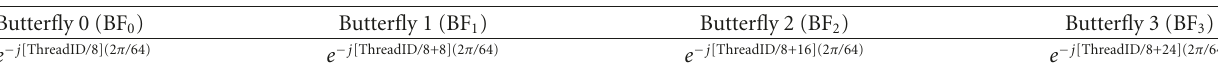
Table 5: Stage 4